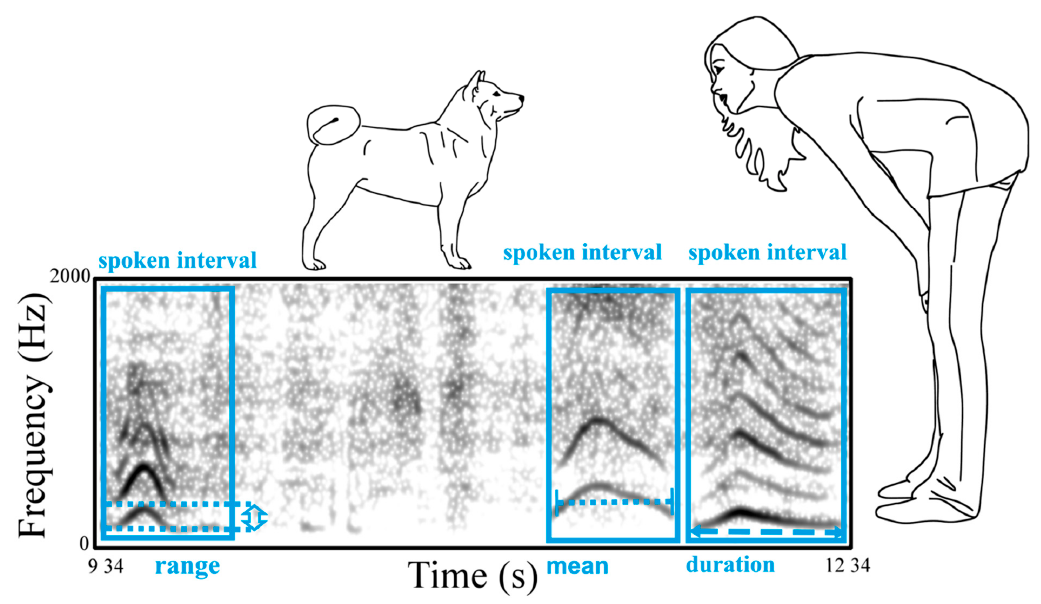
Figure 2. Spectrogram of a female owner talking to her dog during a reunion of the ASS procedure with illustrations of the spoken intervals and the measured variables mean f0 (average f0), voiced duration, and f0 range.